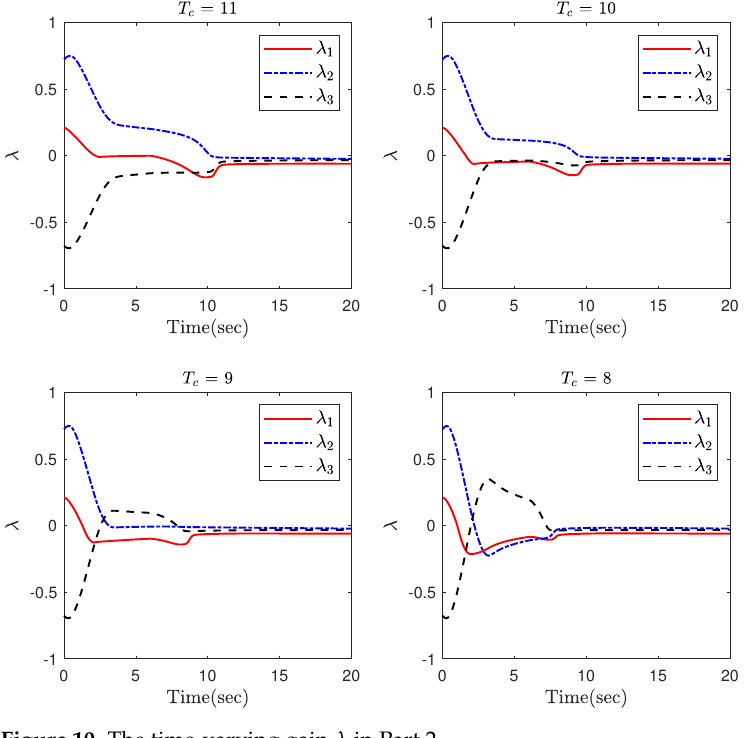
Figure 10. The time-varying gain λ in Part 2.